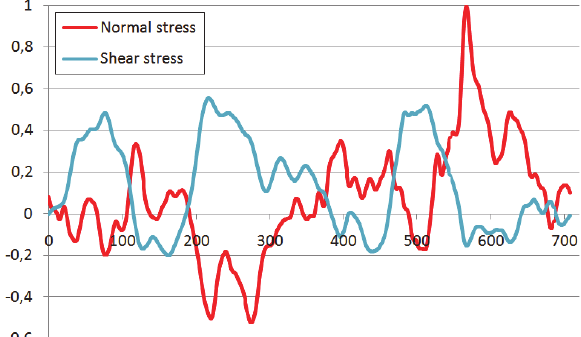
Figure 7. Normal and shear stress distribution over one firing sequence (rotation of crankshaft by 720°) at one selected notch of a 16- cylinder gas